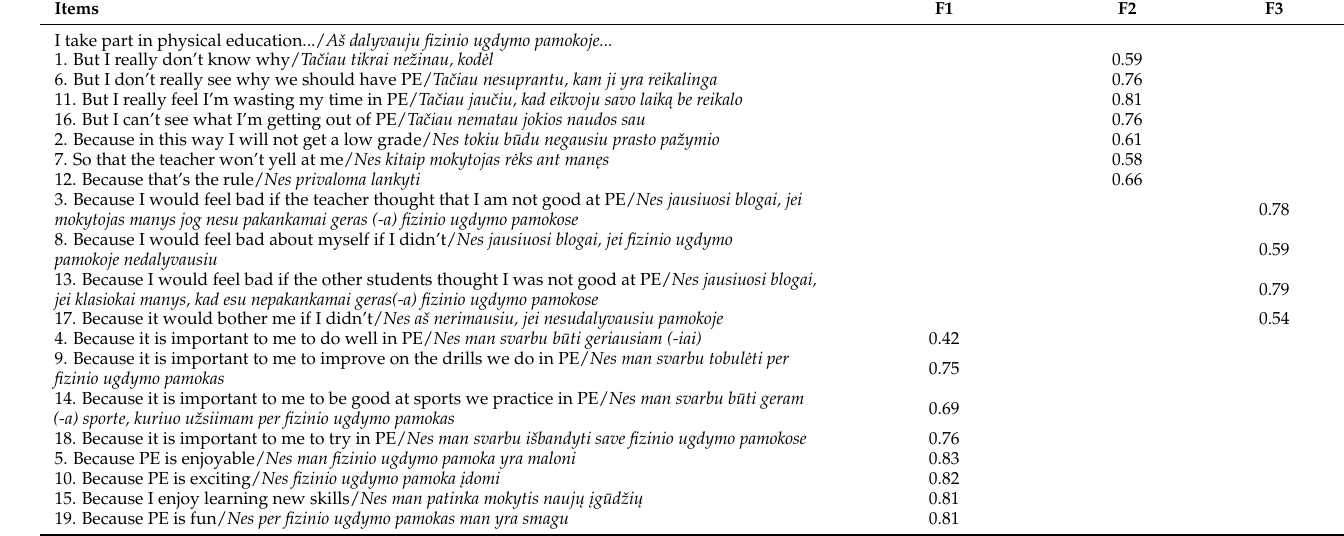
Table A2. The Revised Perceived Locus of Causality in Physical Education Scale (PLOC-R) En- glish/ Lithuanian statements with the factor loadings from the exploratory factor analysis ( n = 715).